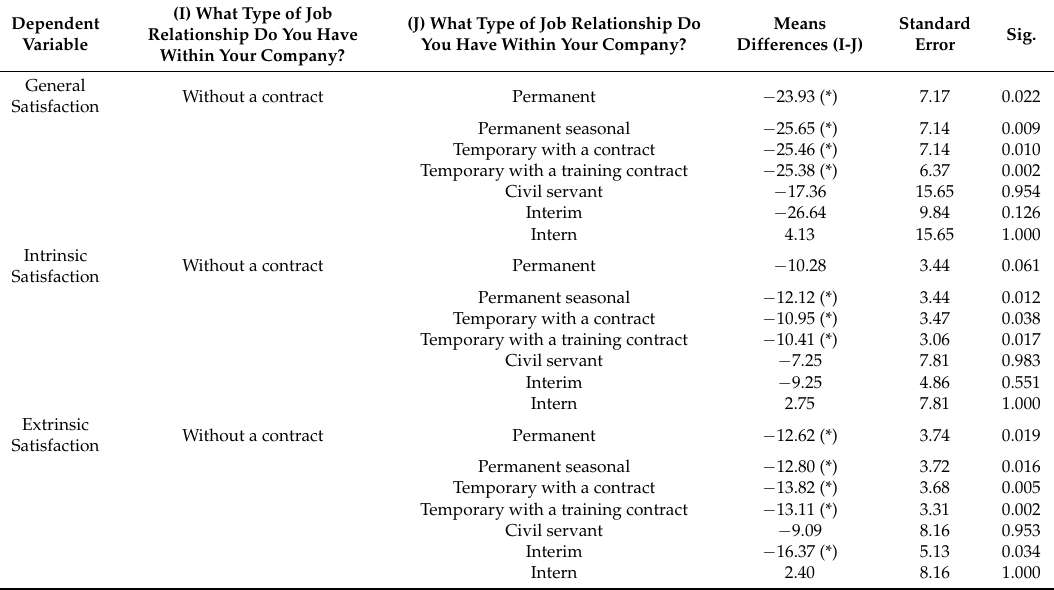
Table 3. Comparison between groups (post hoc Tukey’s HSD